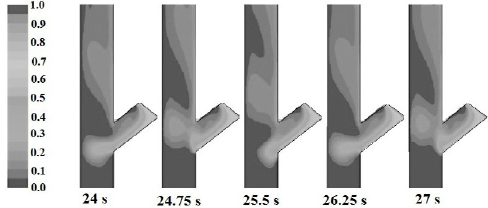
Fig. 6. Profiles of instantaneous volume fraction of solids in the entrance region at five different instants.